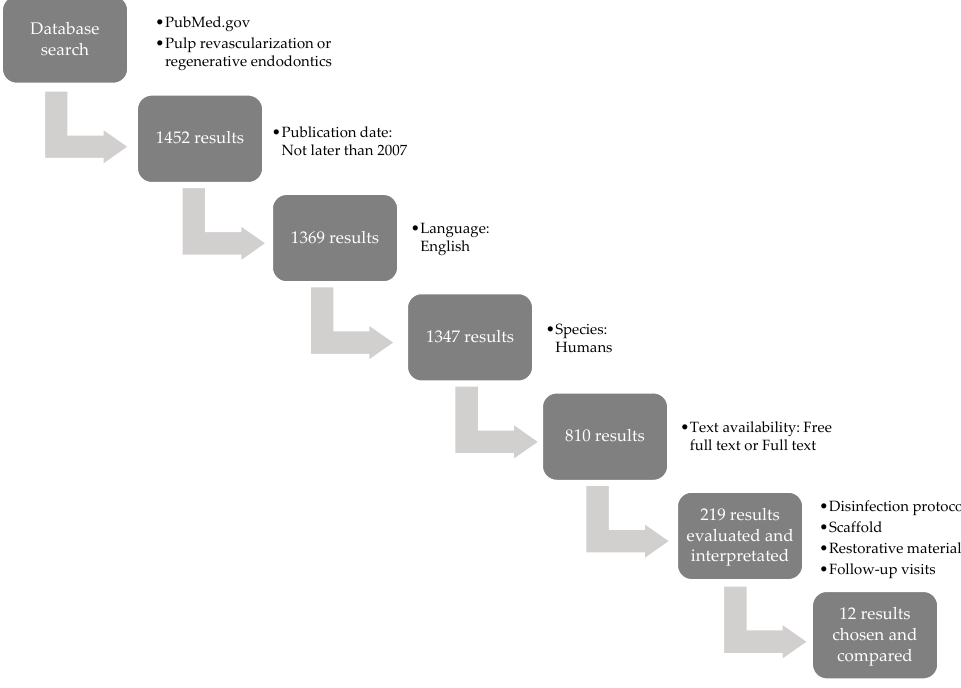
Figure 1. Flowchart presenting database search strategy.